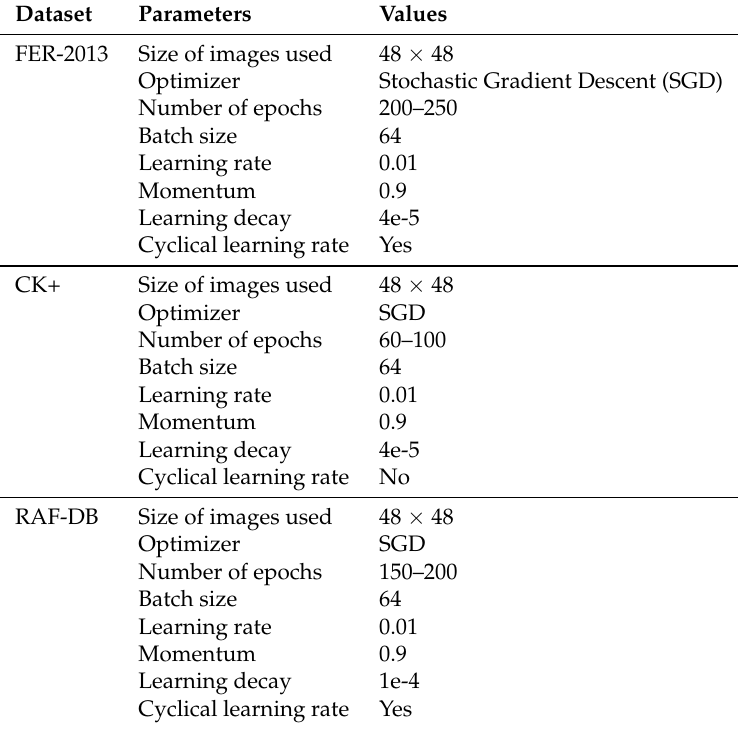
Table 1. Settings of parameters used for training of eXnet on all three